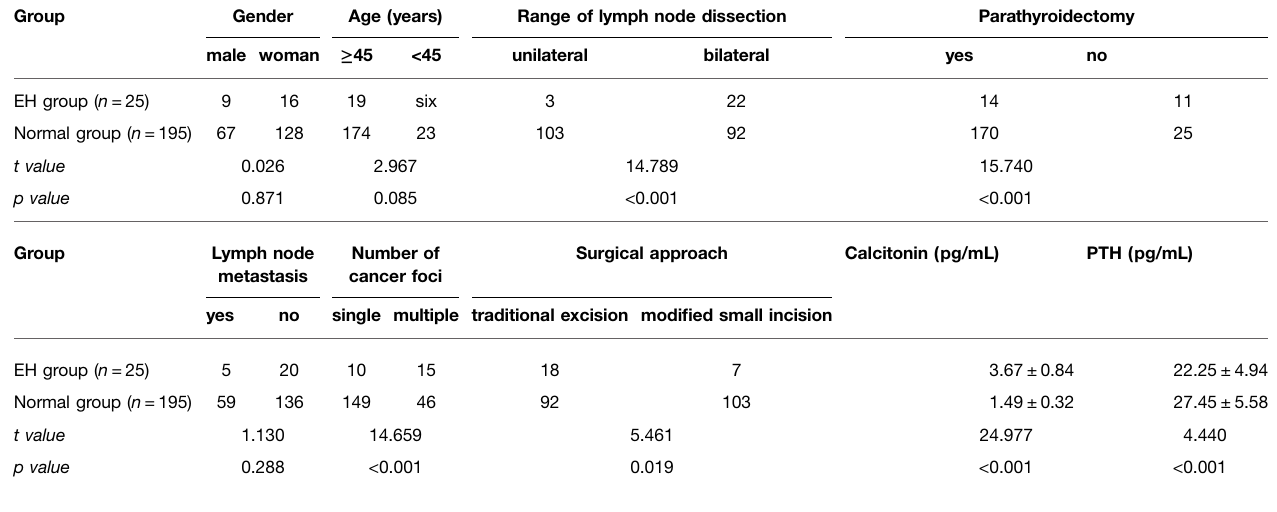
TABLE 1 | Univariate analysis of postoperative EH in